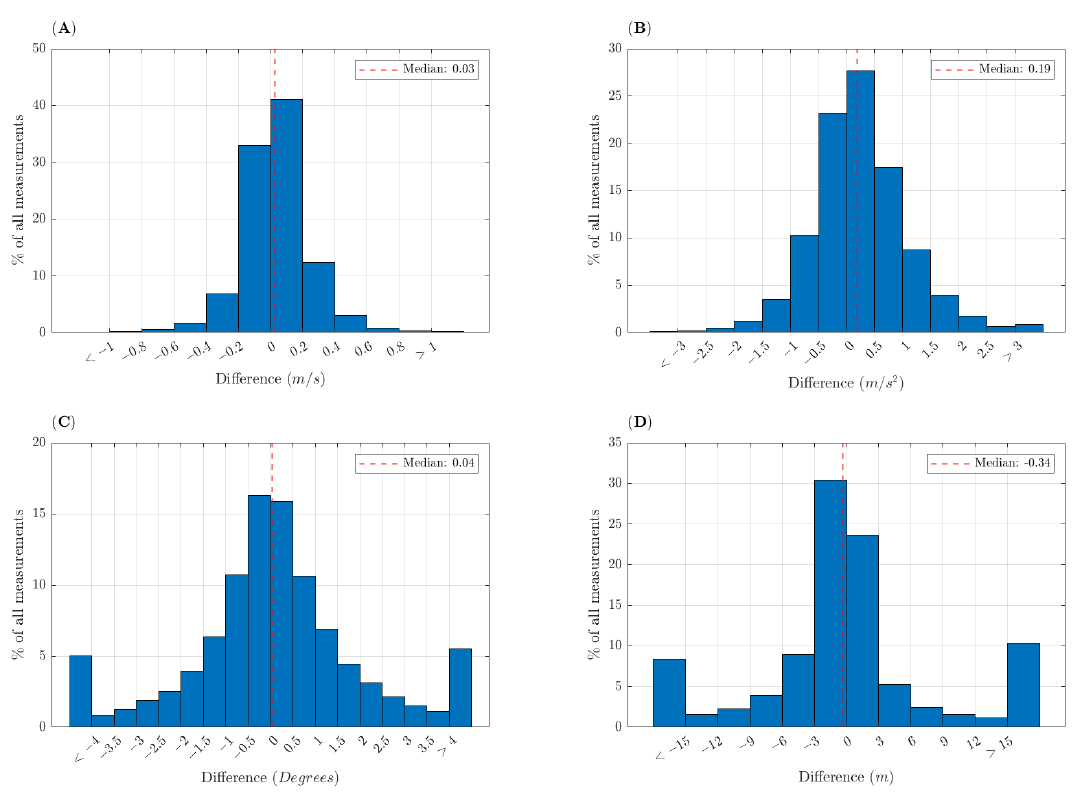
Figure 2. ( A ) Histograms for error in speed (Δ| v |), ( B ) acceleration (Δ| a |), ( C ) trajectory incline ( ΔIncline) and ( D ) turn radius ( ΔTurn radius). The histograms use all data from recreational and competitive skiing pooled together.